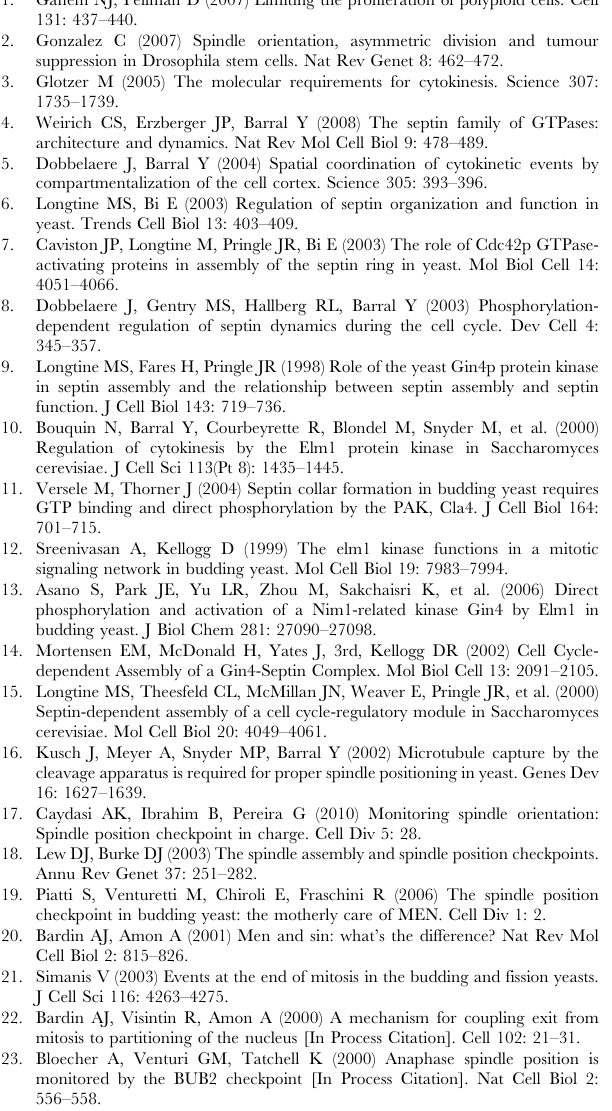
Table S1 Yeast strains used in this study.